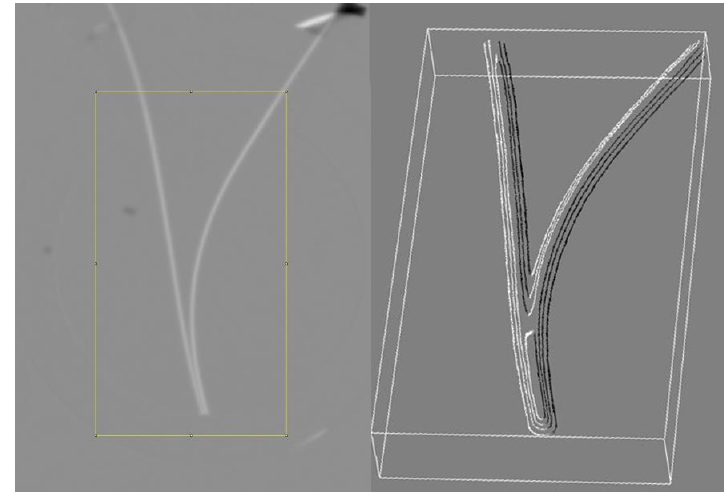
Figure 1. Image produced by subtracting the natural logarithm of the neutron attenuation in the distilled water filled cell with and without two strips of Nafion. The yellow outline shows the region of interest for creating the 3D surface plot shown on the